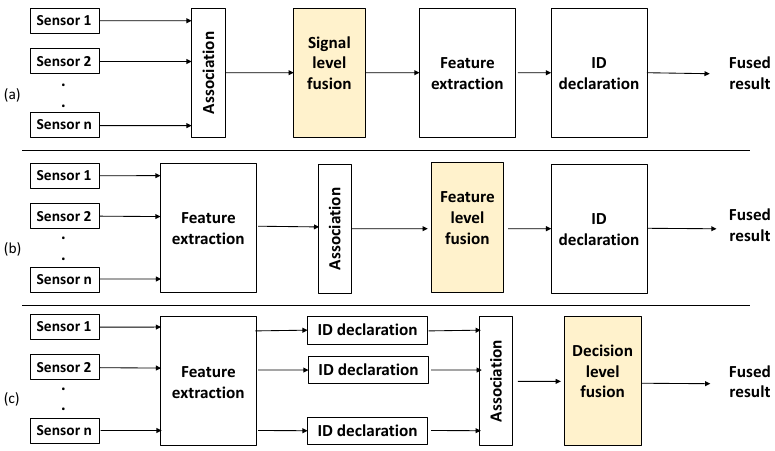
Figure 1. Data fusion at three different levels: ( a ) Signal-level fusion, ( b ) feature-level fusion, and ( c ) decision-level